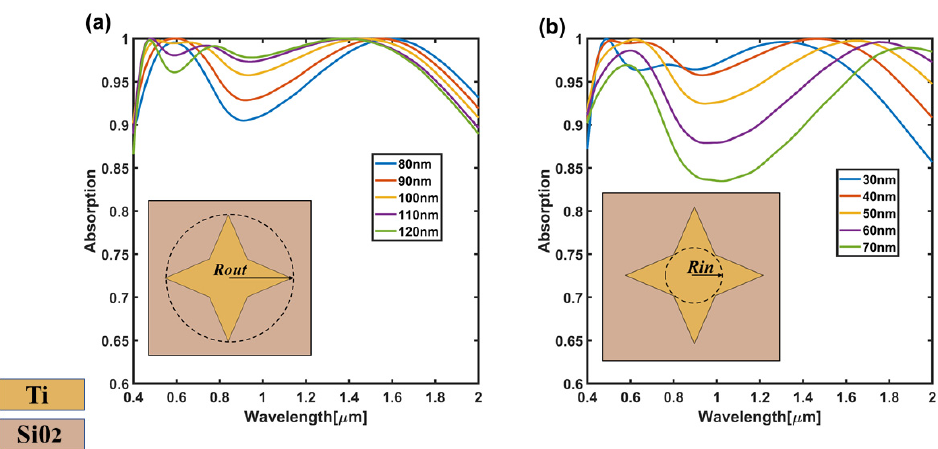
Figure 4. Absorption efficiency diagram under various cases . ( a ) The absorption efficiency diagram corresponding to case1 and case2; ( b ) The absorption efficiency diagram corresponding to case3 and case4.